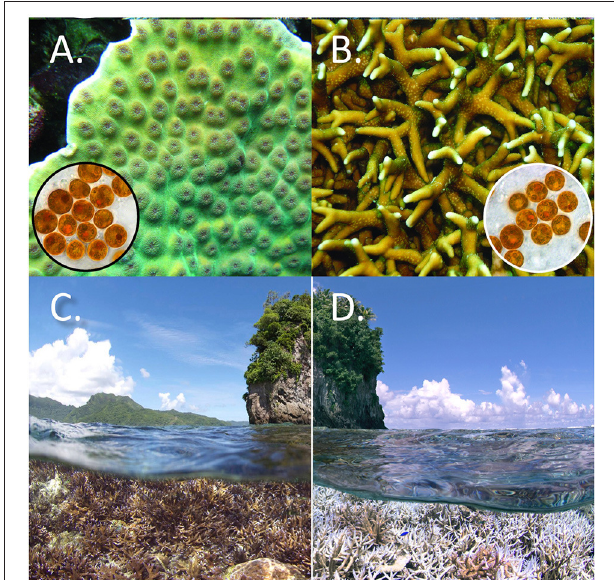
FIGURE 4 | (A) Scleractinian coral ( Turbinaria sp) and (B) Hydrozoan coral ( Millepora sp) showing respective Symbiodinium symbionts (each brown cell is about 10 µ m in diameter) removed from coral tissues; Credit for (A,B) : Todd LaJeunesse, from Pennsylvania State University. (https://www.flickr.com/ photos/tags/linkflickrset72157631573740050). (C) The photo at left, taken in December 2014, shows coral reef near runway in American Samoa, without obvious bleaching of corals. (D) The photo at right shows the same coral reef, now heavily bleached, in February 2014 (Credit for C , D : Richard Vevers, The Ocean